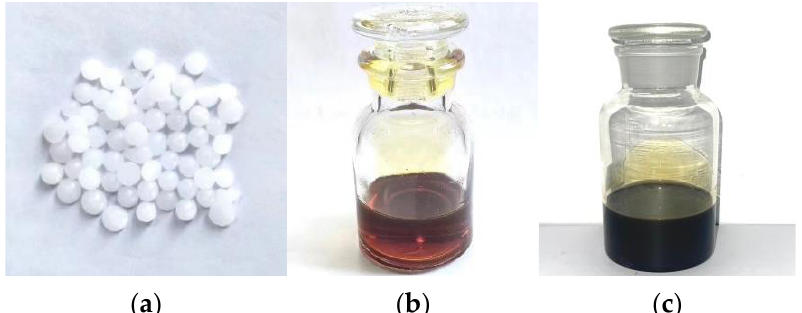
Figure 1. Images of the WMA additives and rejuvenating agent: ( a ) Sasobit; ( b ) Evotherm-M1; ( c ) ZGSB.